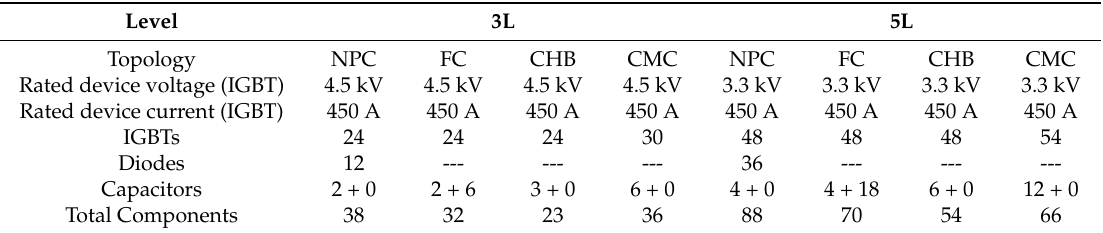
Table 2. Comparison of different topologies (V ll_rms = 3 kV, I ph_rms = 115.5 A, P = 600 kW).